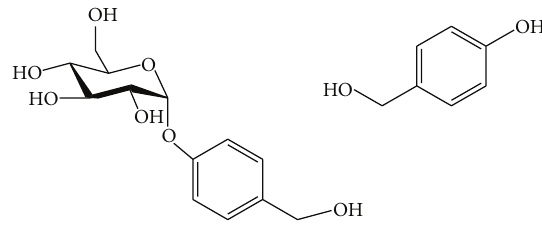
Figure 5: Chemical structure of phenolic compounds: (16) gas- trodin and (17) p -Hydroxybenzyl